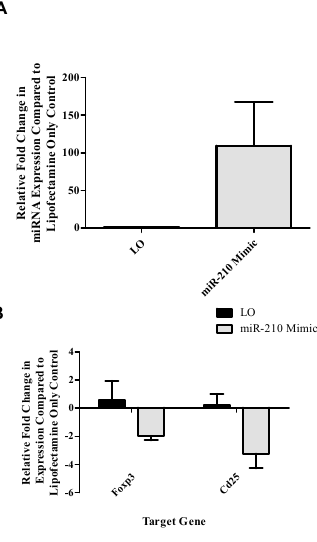
Figure 2. Ex vivo miR ‐ 210 mimic augmentation reveals potential inhibitory effect of miR ‐ 210 on regulatory T cell (T reg ) ‐ related genes in dLN cells. ( A ) Intracellular miR ‐ 210 was quantified via RT ‐ PCR in ex vivo stimulated samples 72 h following transfection with lipofectamine only control (LO) or miR-210 mimic. ( B ) foxp3 and cd25 ( il2r α ) were investigated as potential miRNA targets via RT-PCR. Bars represent mean relative fold change ( ± SE) of 3 replicates per